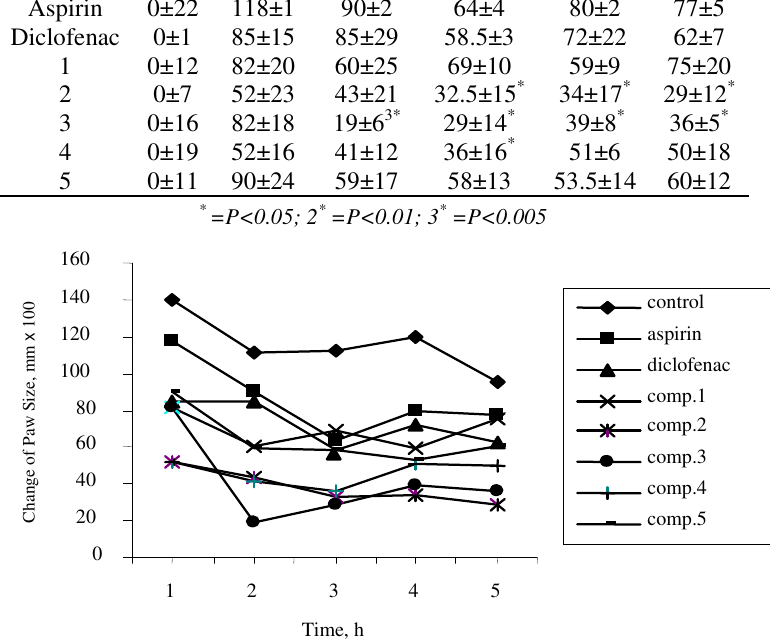
Figure 10. Carrageenan induced inflammation test of histidine derivatives The injection of carrageenan increased in leukocyte infiltration and accumulation of PGE2, LTB4 and nitrate. Carrageenan also induced elevated expression